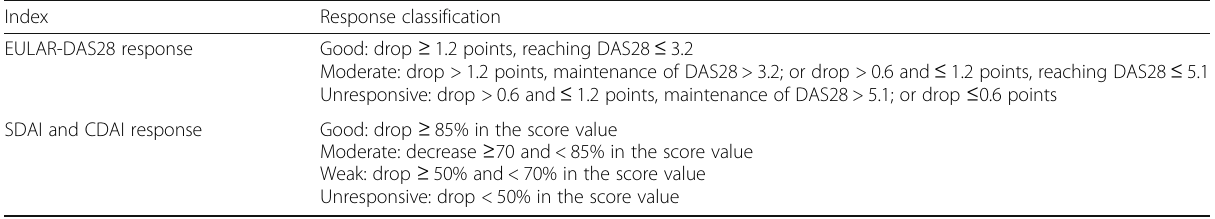
Table 6 Classification of the therapeutic response in rheumatoid arthritis according to the variation in scores of the composite disease activity